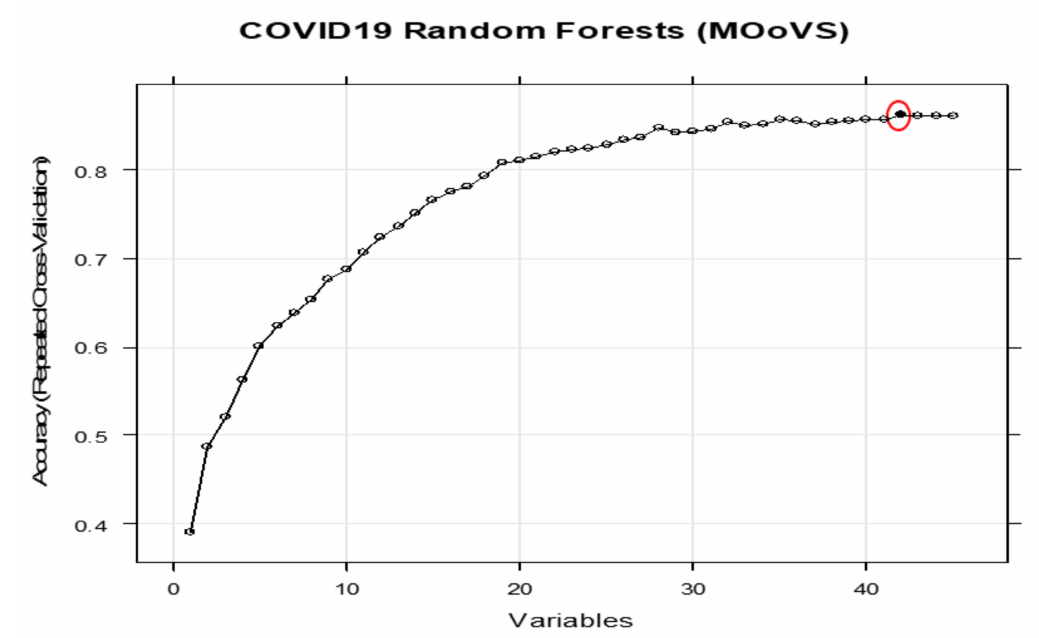
Figure 2. Performance of the RFE based on the ranks of the features of MOoVS. The red circle shows the maximum achievable performance based on the best combination of variables.